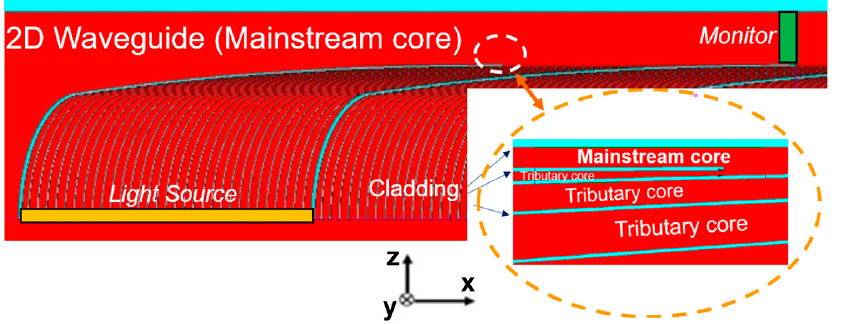
Figure 6. The detailed structure of discrete-translational-symmetry waveguide (DTSWG), overall configuration for which is given in Figure 1. The 2D waveguide (mainstream core) is 15 m thick, the height of the vertical lower partial ellipse is 36 m, and the length of the horizontal upper partial ellipse is about 140 m. The thickness of the thin (thick) cladding layer (pale blue) of the curved tributary waveguides is 0.4 m (1.0 m), and that of the core layer is 2.66 m. The spacing between the thick cladding layer of the curved tributary waveguides is 85 m.